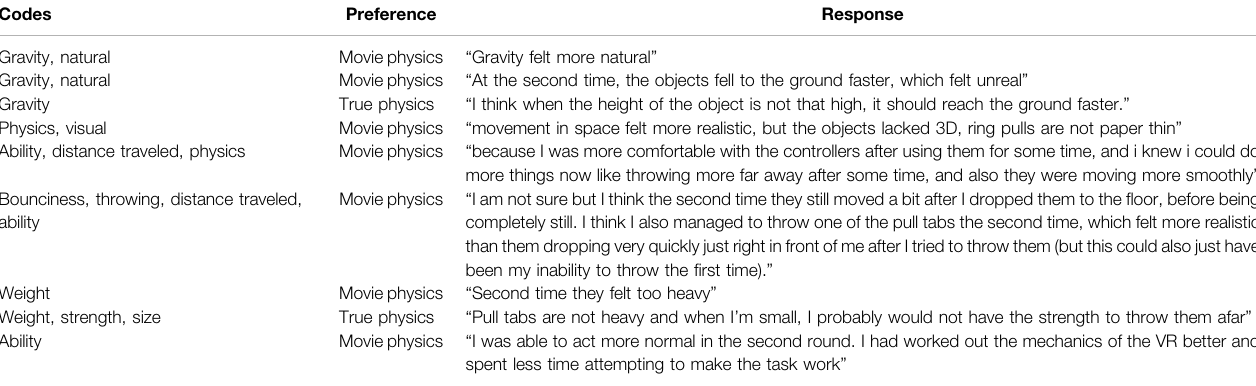
TABLE 1 | Examples of O1 responses (justi fi cation to realism ) in Study 1. Codes